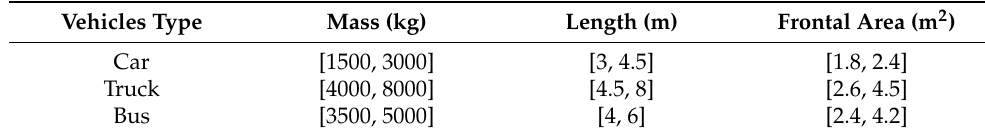
Table 4. Vehicles’ parameters in the heterogeneous platoon.